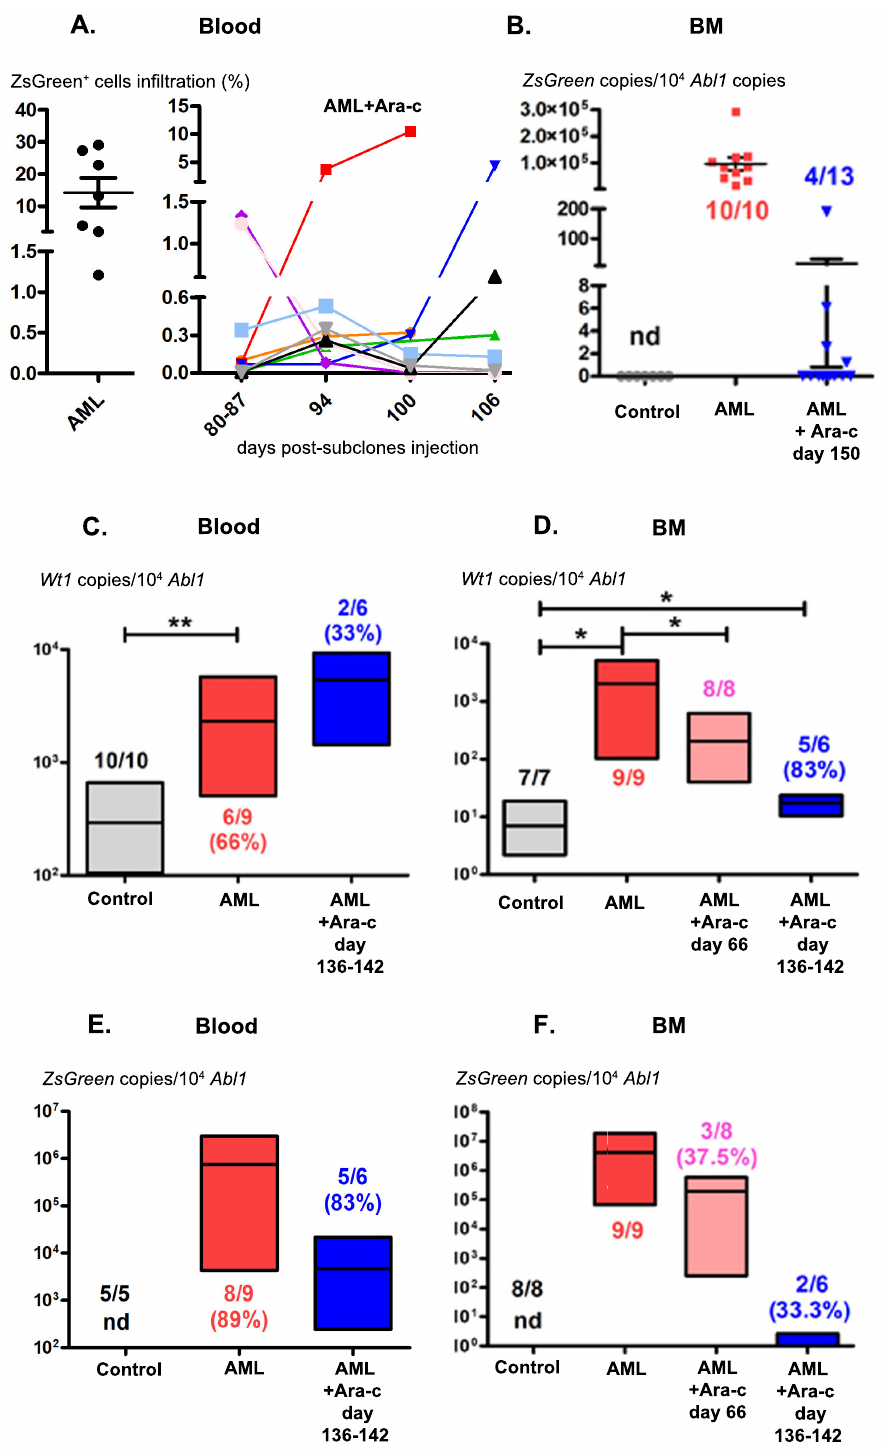
Fig 5. Detection of residual leukemic cells in AML-surviving mice after injection of B11/C5/E7 subclones expressing or not expressing WT1. (A) Percentages of ZSGREEN+ cells determined by flow cytometry in AML- succumbing (n = 7) and AML-surviving mice (n = 15) after B11/C5/E7 injection and Ara-c treatment, respectively. (B) RT-qPCR evaluation of ZsGreen copies and normalization per 10 4 Abl1 copies in the BM of control (n = 7), leukemic (n = 10) and disease-free mice after Ara-c treatment (n = 13). Determination of Wt1 copies/10 4 Abl1 in peripheral blood (PB) (C) and BM (D) in control, AML-bearing, and AML-surviving mice with Ara-c treatment 66 and 136–142